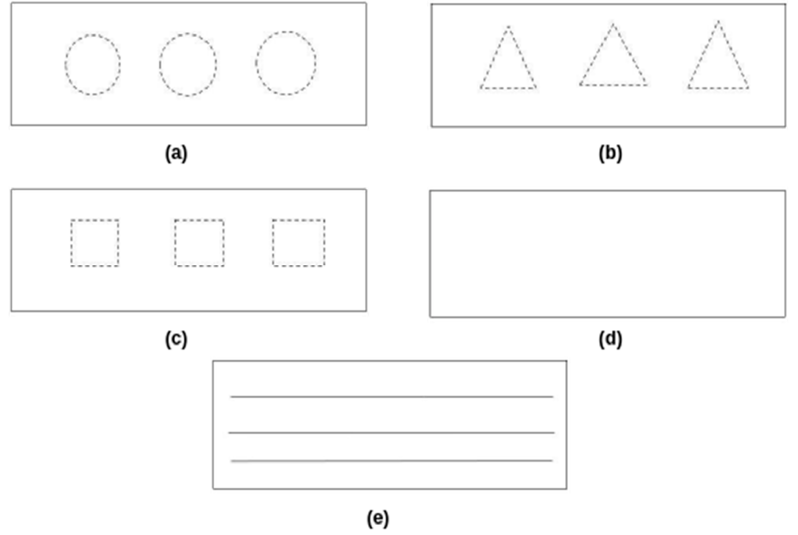
Figure 2. ( a ) Task 1 with the template for drawing circles, ( b ) Task 2 with the template for drawing triangles, ( c ) Task 3 with the template for drawing squares, ( d ) Template for tasks without an outline or ruled lines to guide, ( e ) Template for tasks with outline ruled lines to guide. Task 2: a triangle shape drawing task on a template with outlines that marked the shape to be drawn, as shown in Figure 2b. Task 3: a square shape drawing task on a template with outlines that marked the shape to be drawn, as shown in Figure 2c.